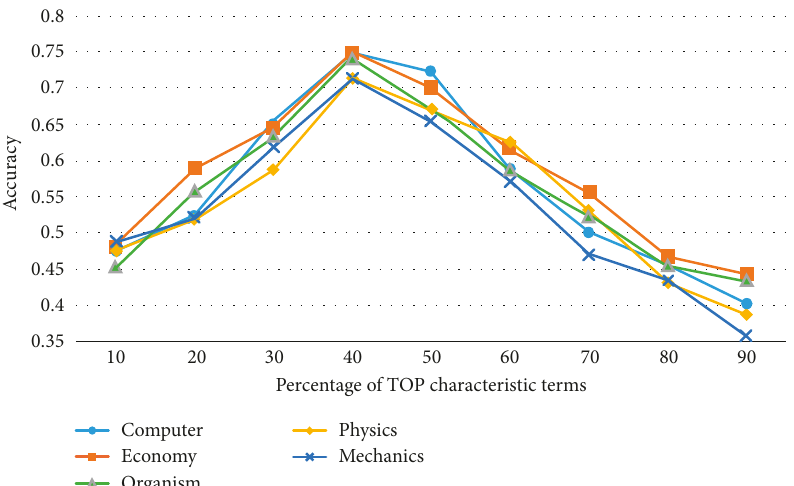
Figure 5: Accuracy comparison of various percentage top characteristic terms.